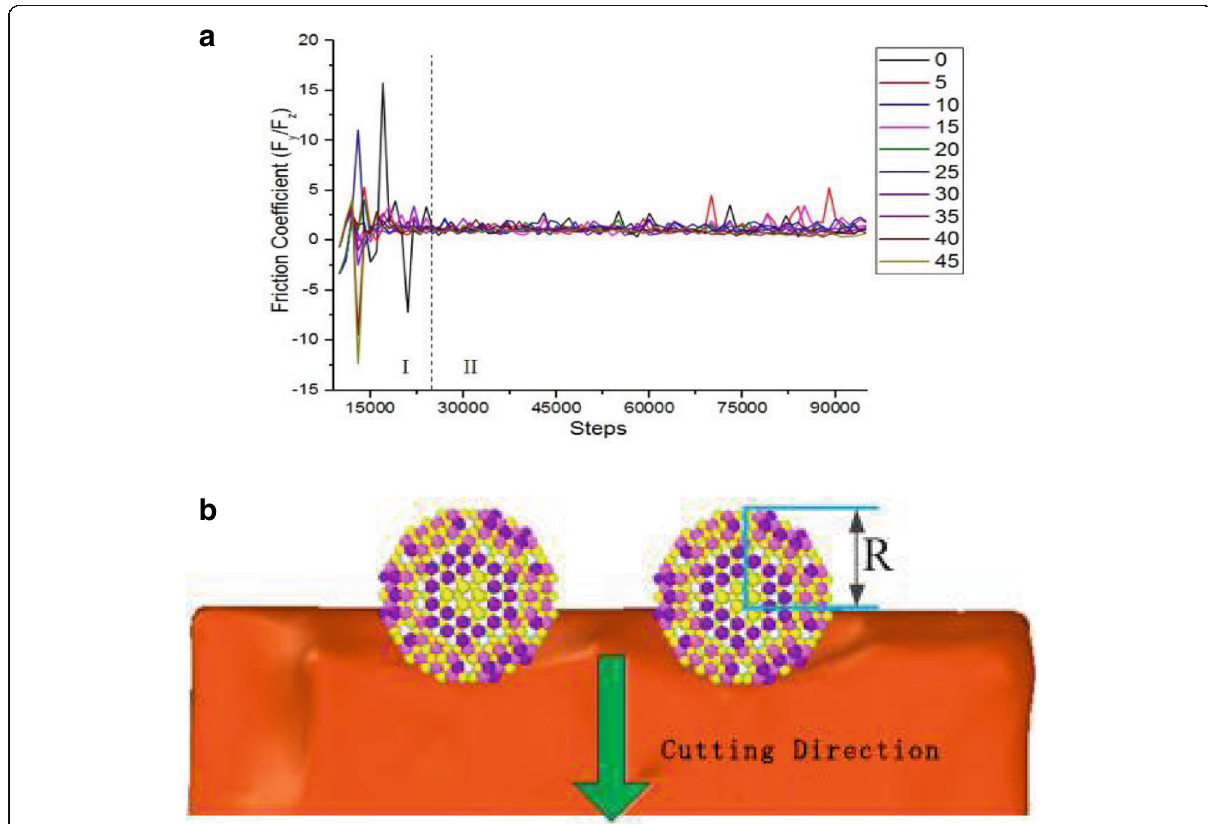
Fig. 13 Friction coefficients of different cutting angles. Figure 13 is the changes of the frictional coefficients during SIC particles cutting single crystal copper from different angles. The change in cutting angle did not cause significant changes in friction coefficient. It described two kinds of coefficient of friction in contact with the relevant atoms in the cutting process, regardless of the cutting mode. a Friction coefficient variation curve with cutting angle. b Instantaneous structure when SiC abrasive grains move 7.5